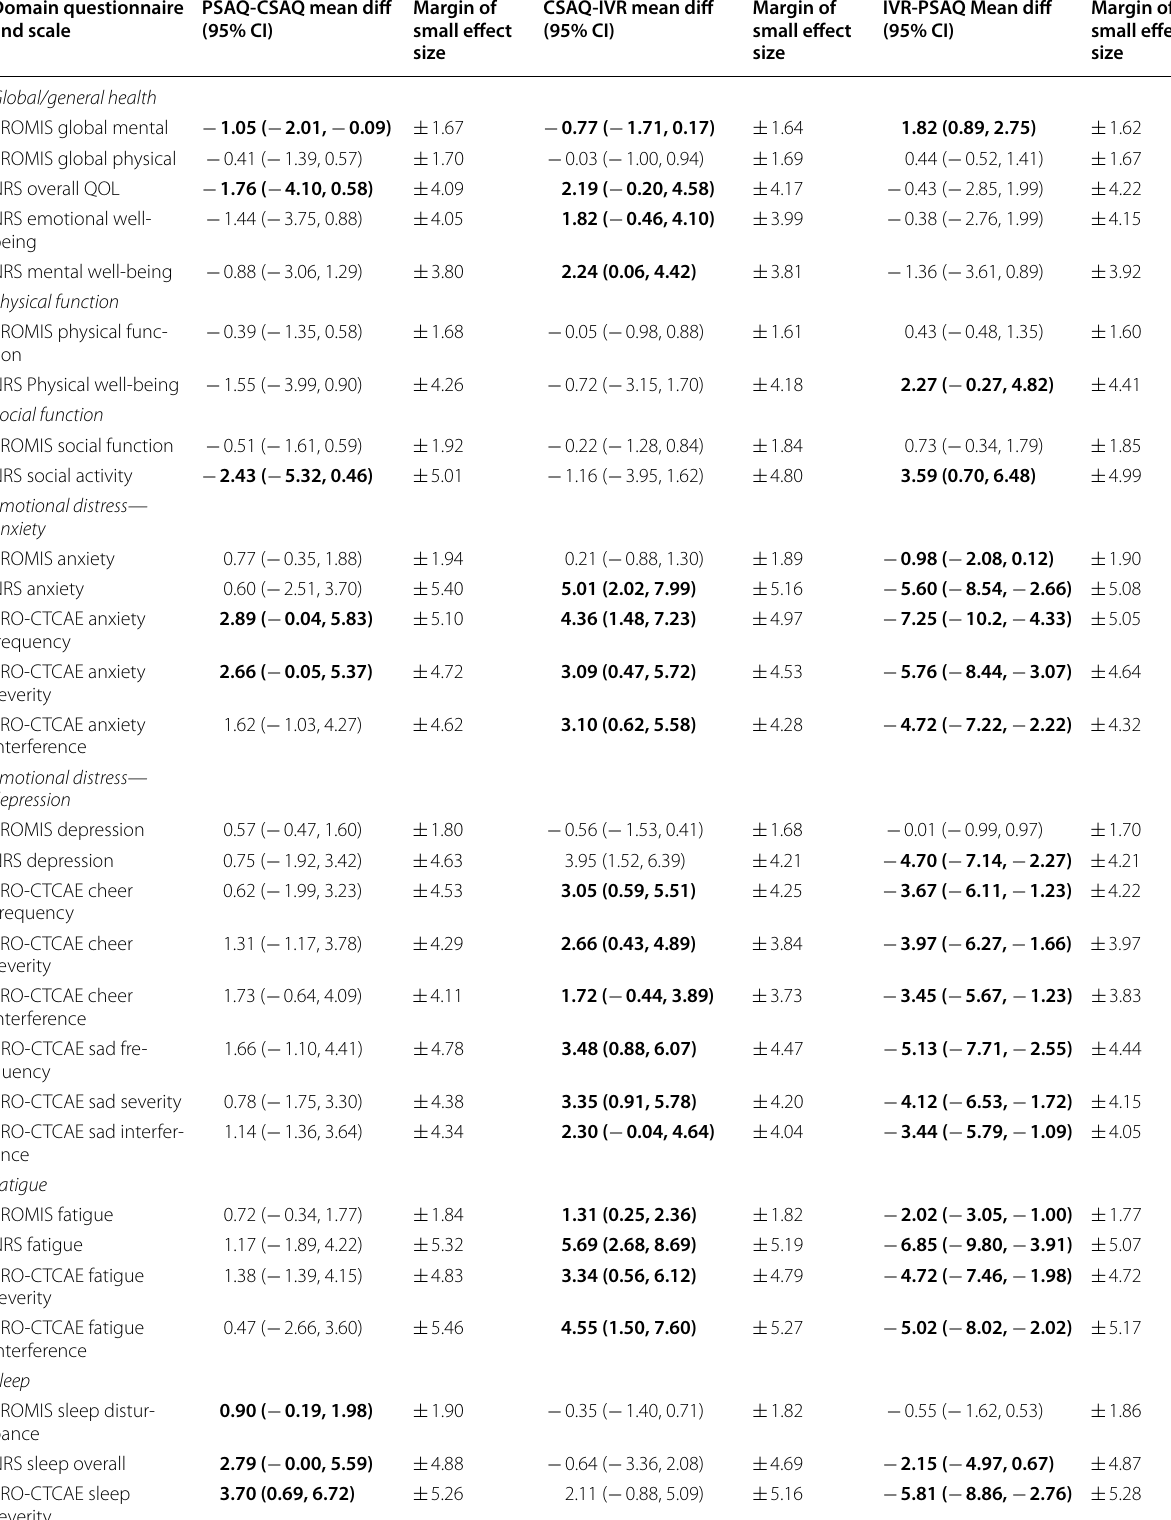
Table 4 Differences in HRQOL scores and margins of small effect size by mode of administration Domain questionnaire and